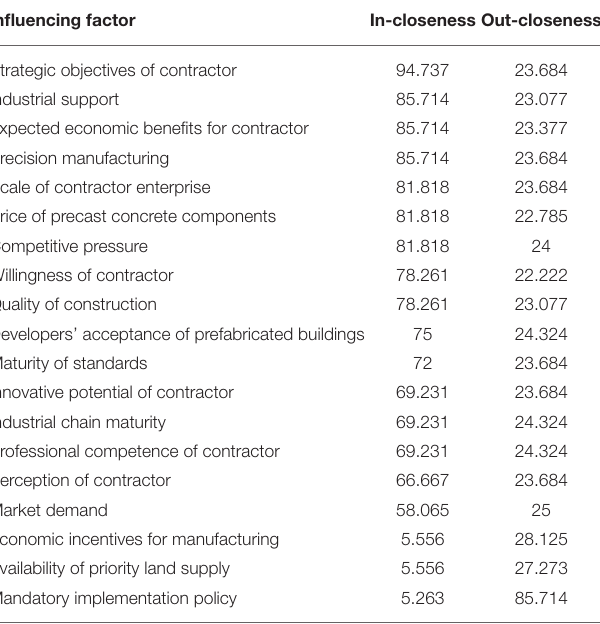
TABLE 4 | Analysis results of closeness centrality for influencing